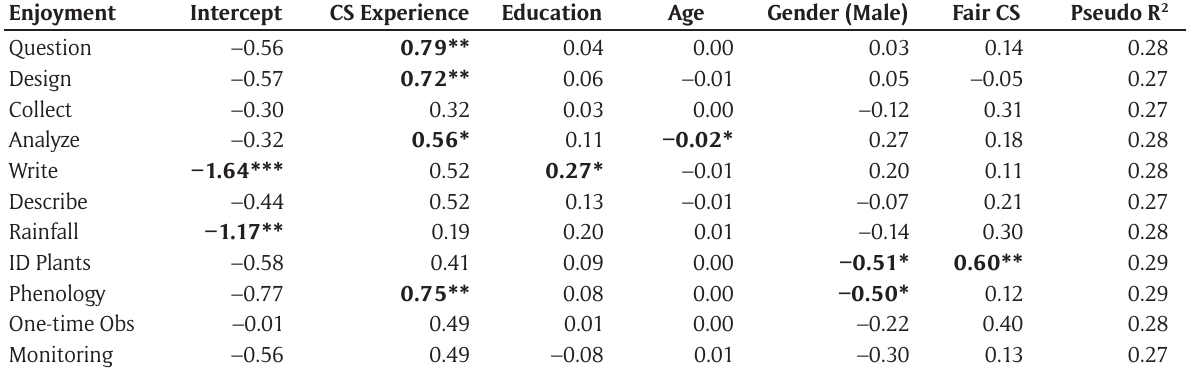
Table 3: Regression coefficients with enjoyment of citizen science activities as dependent variables, and prior citizen science experience, education, age, gender, and participation in other fair activities as independent variables. Bolded coefficients indicate significant p-values: *p < 0.05, **p < 0.01, ***p < .001. N =